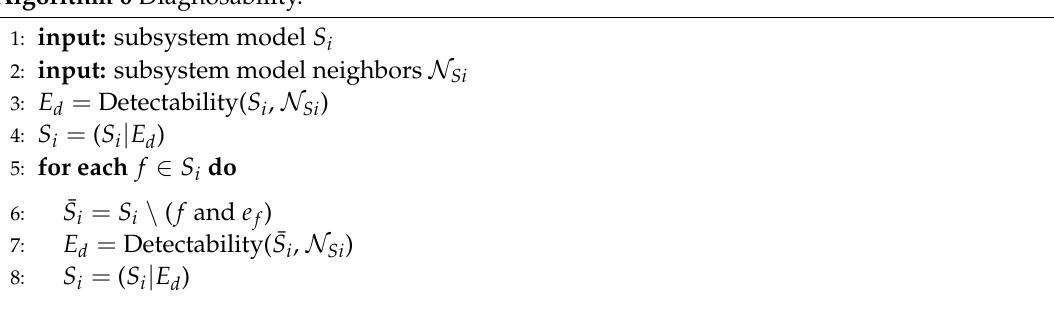
Algorithm 6 Diagnosability.